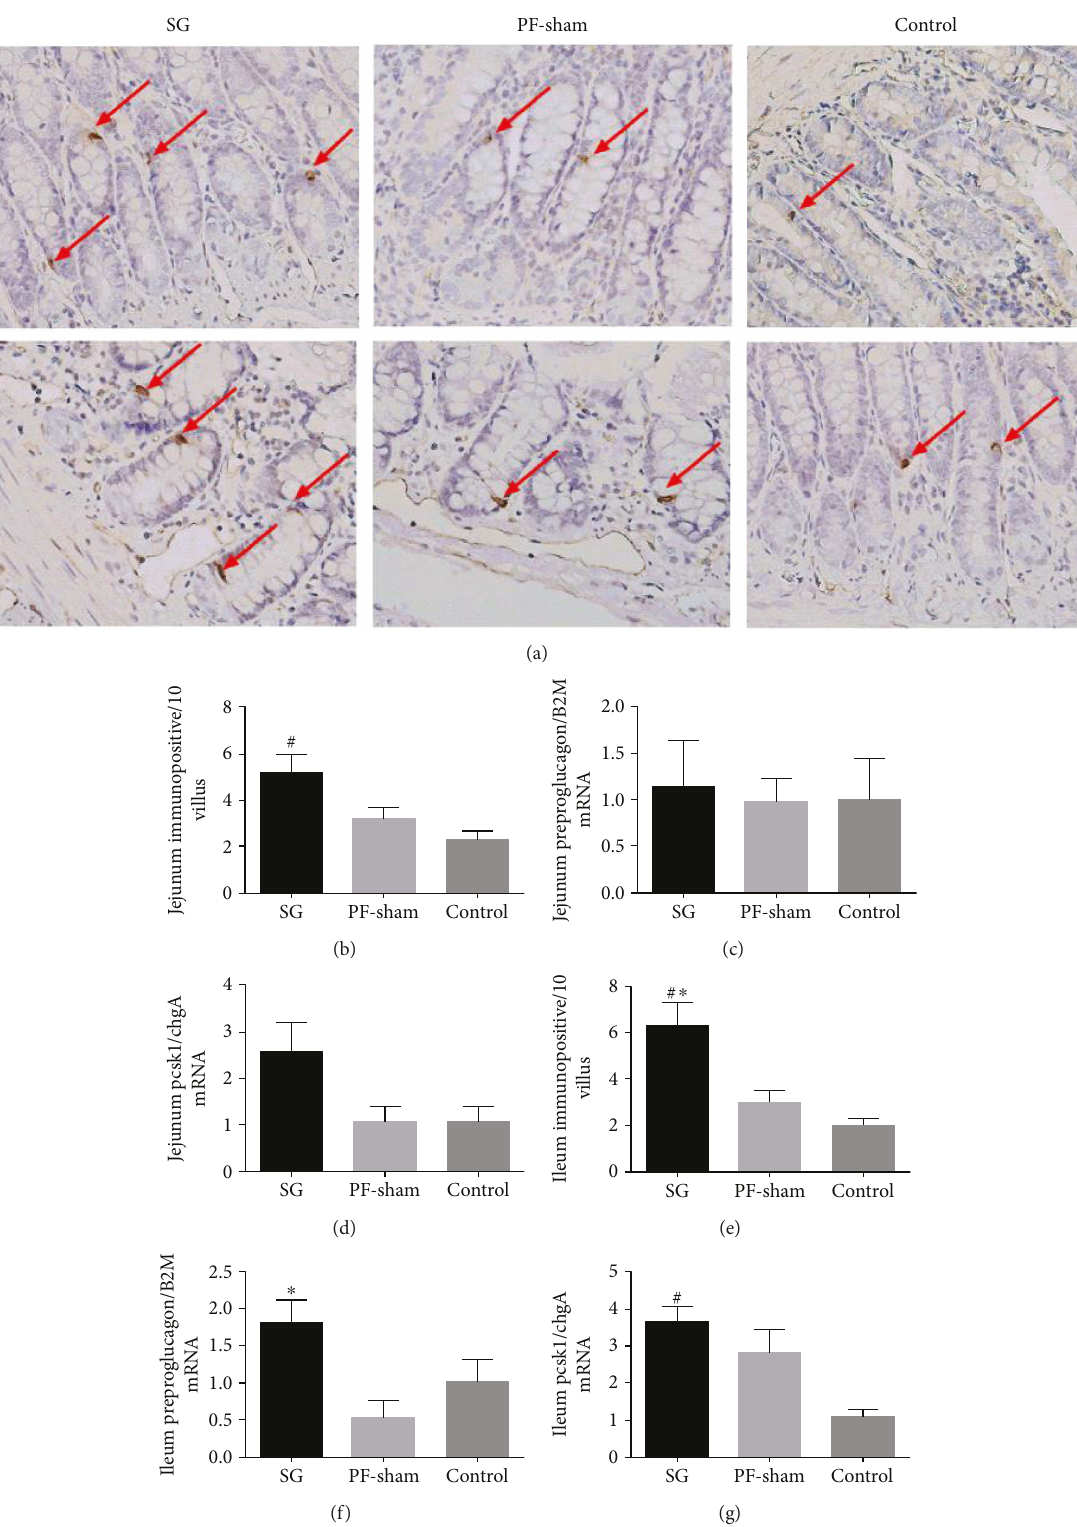
Figure 6: E ff ects of sleeve gastrectomy on the expression levels of the GLP-1 protein and the preproglucagon and PCSK1 genes in jejunal and ileal segments. Representative micrographs (400x magni fi cation) of GLP-1 immunopositive cells (a) and the relative numbers of GLP-1 immunopositive cells (b, e). Expression levels of the preproglucagon (c, f) and PCSK1 genes (d, g) in the jejunum and ileum are shown. Brown GLP-1-positive staining is indicated by arrows. # P < 0 05 versus the controls; ∗ P < 0 05 versus